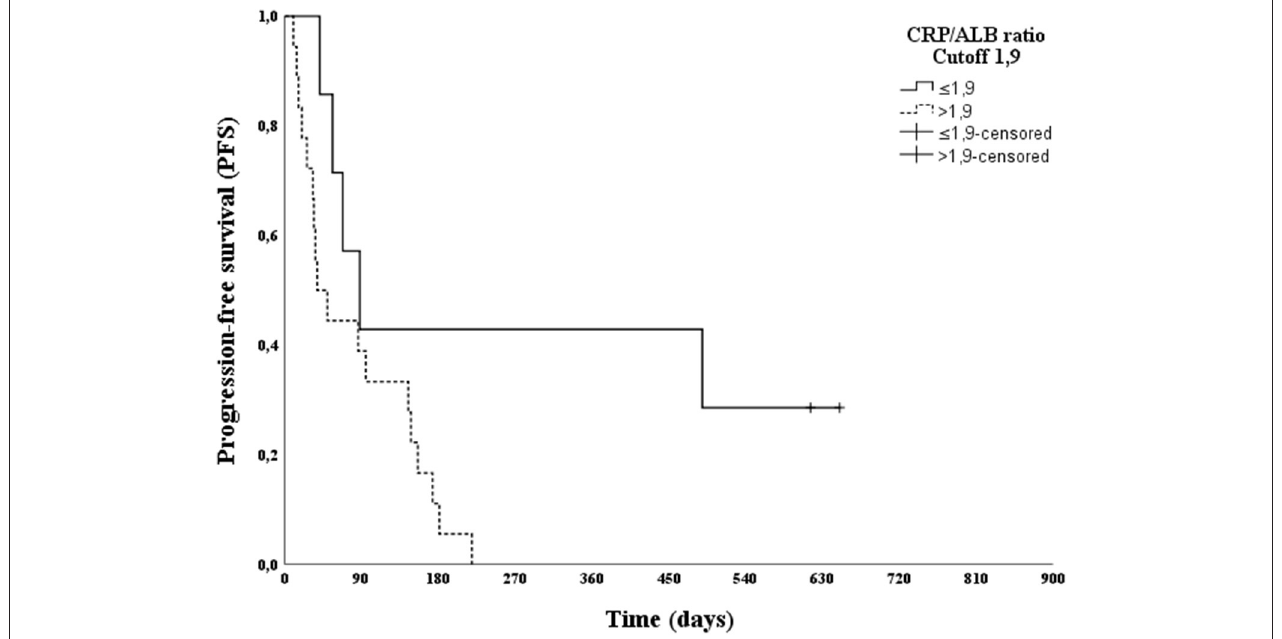
FIGURE 2 | Kaplan–Meier progression-free survival (PFS) curve according to the C-reactive protein/Albumin (CRP/ALB) ratio cut-off point (1.9) in 25 canine patients with oral melanoma.